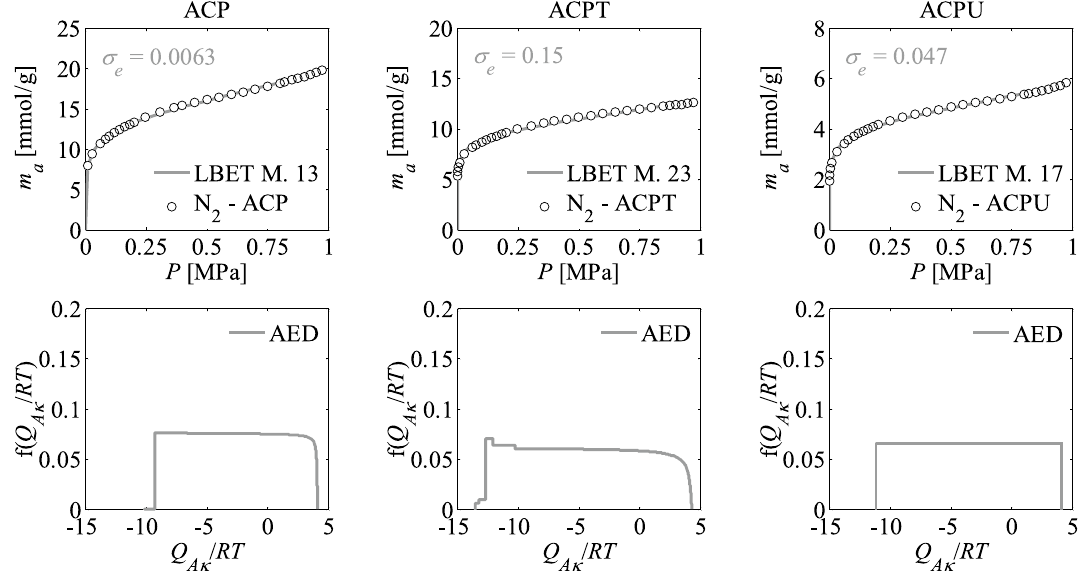
Figure 10. Nitrogen adsorption isotherms and adsorption energy distributions (AED) obtained by applying the LBET method to the experimental data for the activated carbons developed by the process of activation with phosphoric acid (ACP) and subjected to an additional method of thermal (ACPT) and chemical (ACPU) treatments.